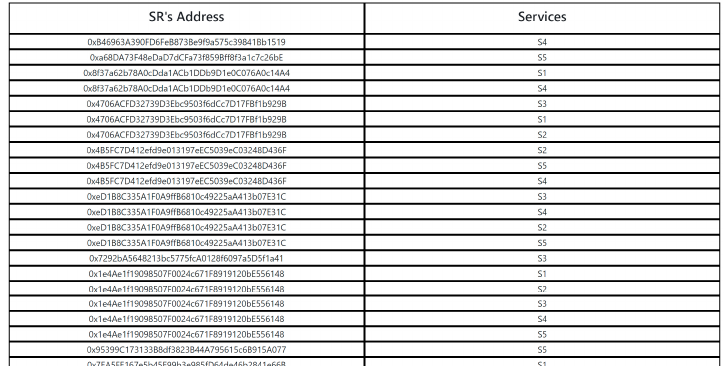
Figure 16. Banned List for Malicious SRs.